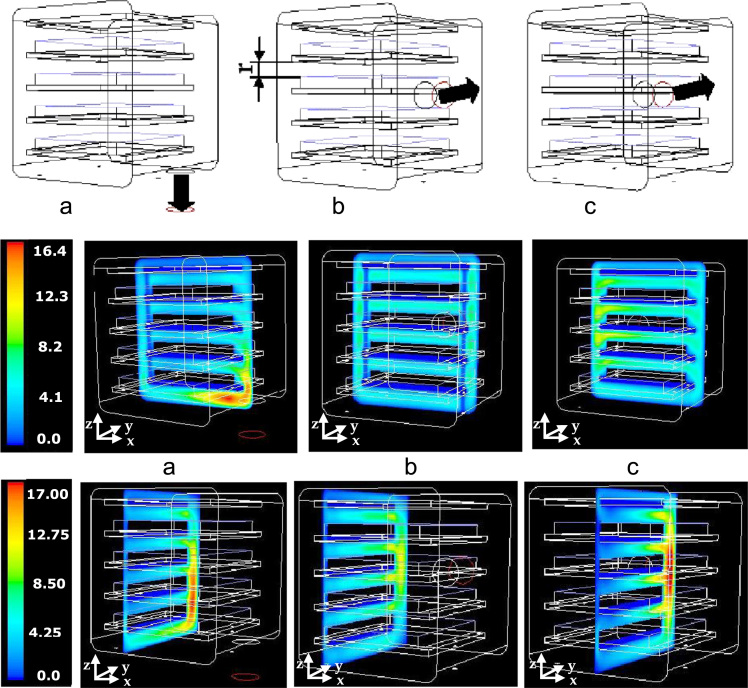
Upper graphs: 3D representation of the small freeze-dryer chamber with the duct in different positions: bottom (a), in the centre of the rear wall (b) and on a side of the rear wall (c). The slab that represents the volume occupied by trays or vials is shown, and the size of the free clearance r, is evidenced. Velocity magnitude (m/s) plotted on x–z plane (middle graphs) and velocity magnitude (m/s) plotted on y–z plane for the S1 case (r=57 mm) for the three configurations; a mass flow rate equal to 4.5·10−5 kg s−1, and outlet pressure 10 Pa, corresponding to typical values experimentally measured in lab operation has been considered in this case.